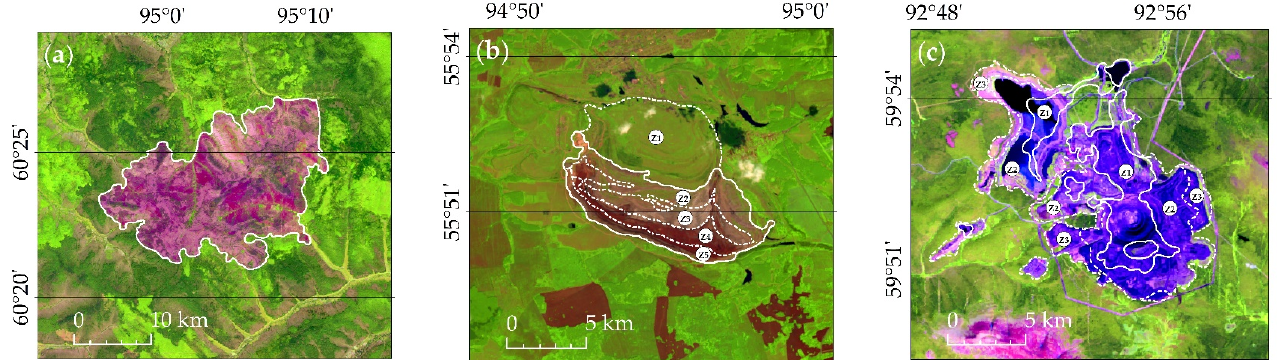
Figure 2. Initial images on natural and technogenic disturbed plots: ( a ) an example of a post-fire plot (burned 2 July–24 July 2018), image from Landsat-8 OLI/TIRS, 12 July 2019; ( b ) technogenic disturbances at the Borodinsky Coal Mine (BCM), Landsat-8 OLI/TIRS, 02 July 2018; and ( c ) technogenic disturbances at the Olimpiada Mining Plant (OMP), 12 July 2019. Plots of different ages (from 1970th up to 2018) are marked as Z1–Z5 polygons.